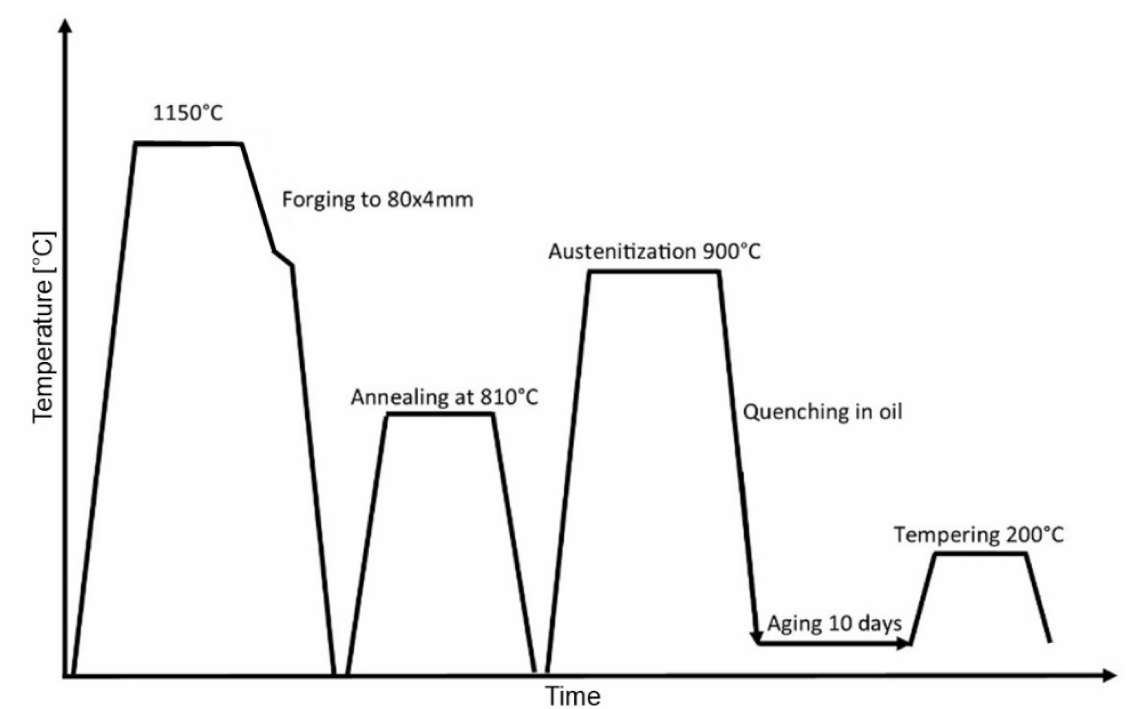
Figure 1. Heat treatment of